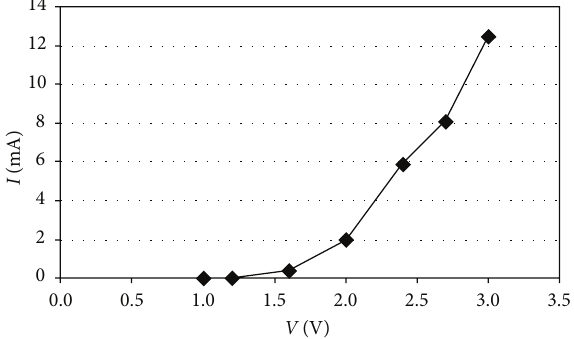
Figure 12: Current (𝐼) -voltage (𝑉) curve of the Standard geometry.